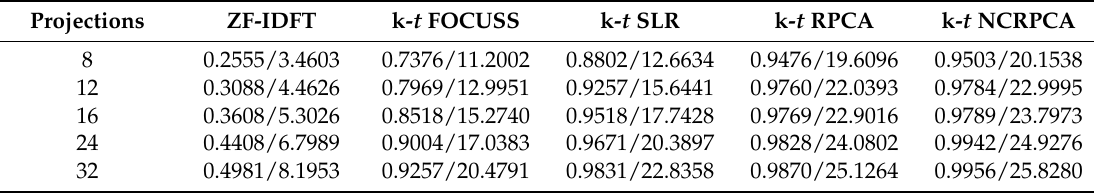
Table 1. SSIM/SER comparison of various reconstruction methods on in vivo axial cardiac MRI dataset for different number of radial projections.